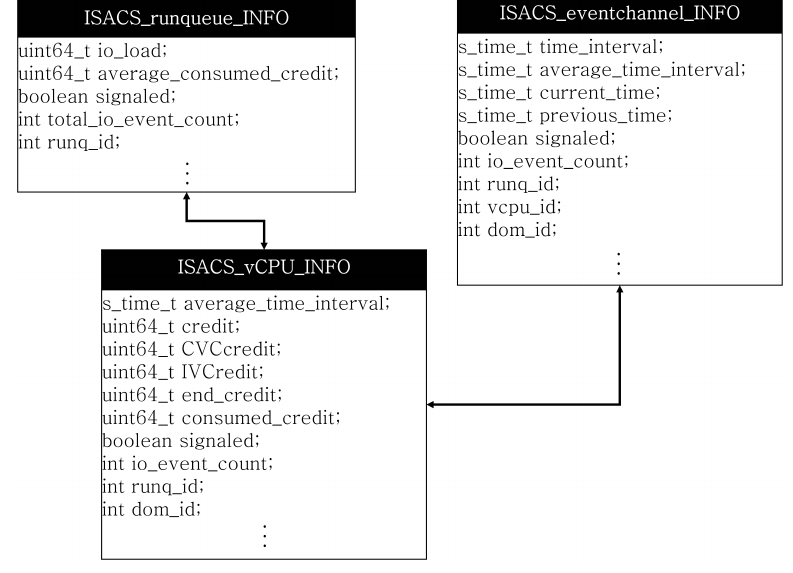
Figure 3. ISACS scheduling